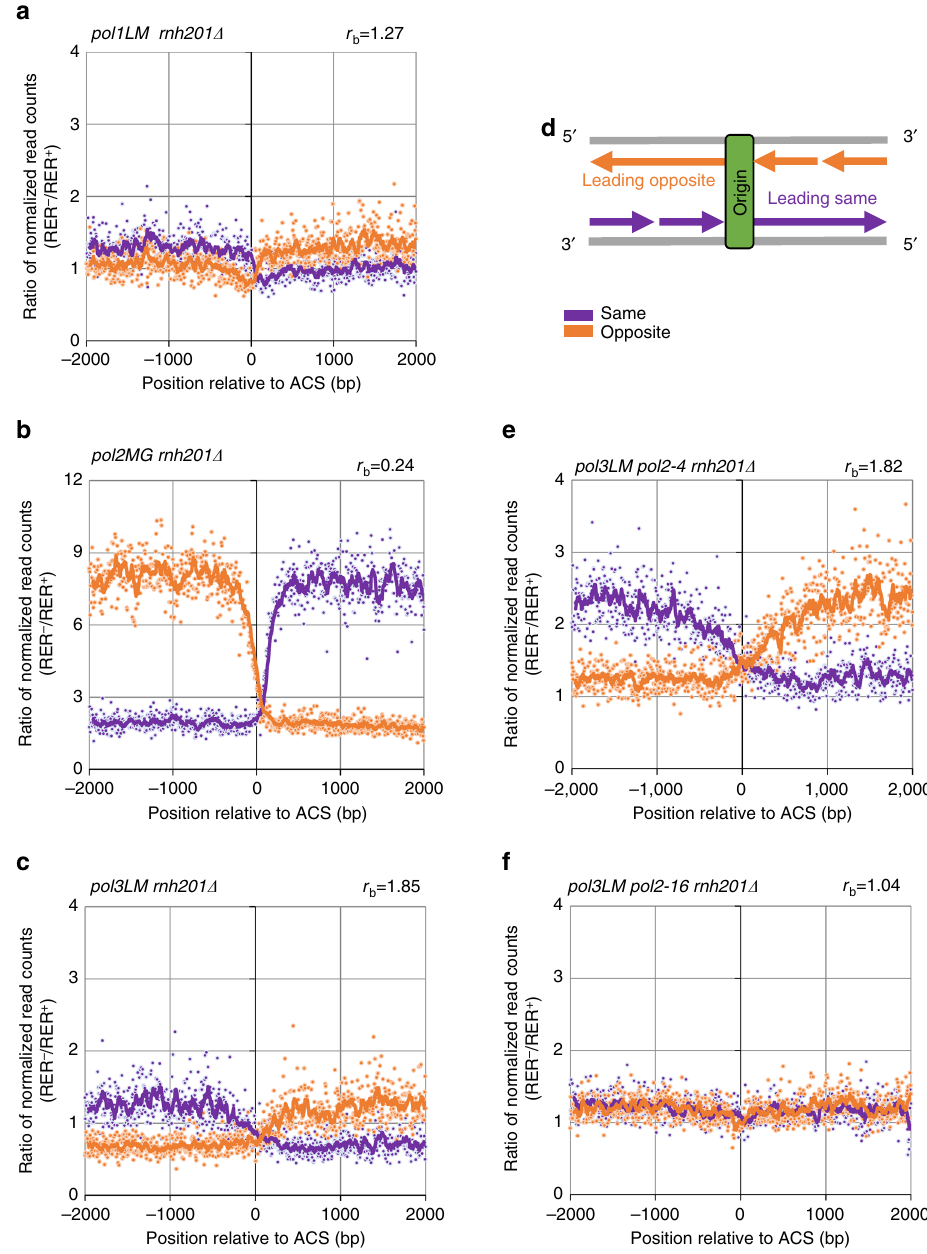
Fig. 3 Ribonucleotides as biomarkers of replicase activity. Meta-analysis of ribonucleotides abundance in the vicinity of 214 replication origins analyzed in previous study 28 , in bins of 5 bp, with 10-bin moving average trend lines. Read counts were normalized as described in Supplementary Methods. Shown are ratios of RER-de fi cient (RER − ) and RER-pro fi cient (RER + ) strains bearing a pol1L868M , b pol2M644G , c pol3L612M , e pol3LM pol2-4 , and f pol3LM pol2-16 mutations. Values on the right above each chart are average lagging-over-leading strand biases ( r b ) (see calculations in Supplementary Methods). For each panel, a representative of two independent measurements is presented. d Schematic representation of DNA replication in the vicinity of replication origin, depicting the leading and lagging strands